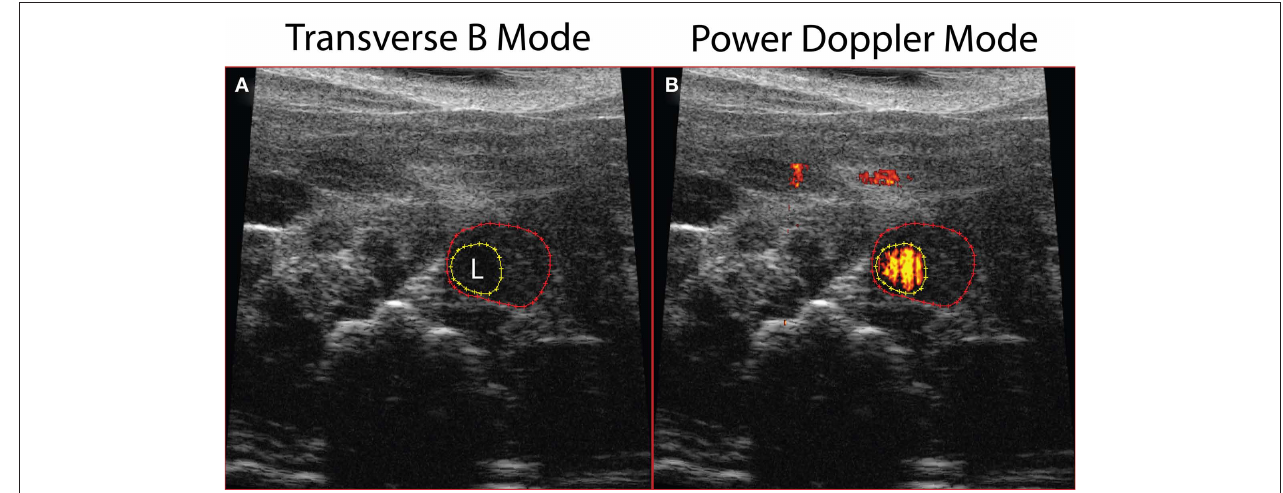
FIguRE 2 | Abdominal aortic dilatation was detected by ultrasound imaging 7 days post-Ang II infusion. (A) Transverse B-mode shows enlargement and remodeling within the aortic wall; (B) Power Doppler Mode demonstrating blood flow in the aortic lumen. Dotted red line outlines external aortic boundary, while the yellow dotted line outlines the lumen (L).